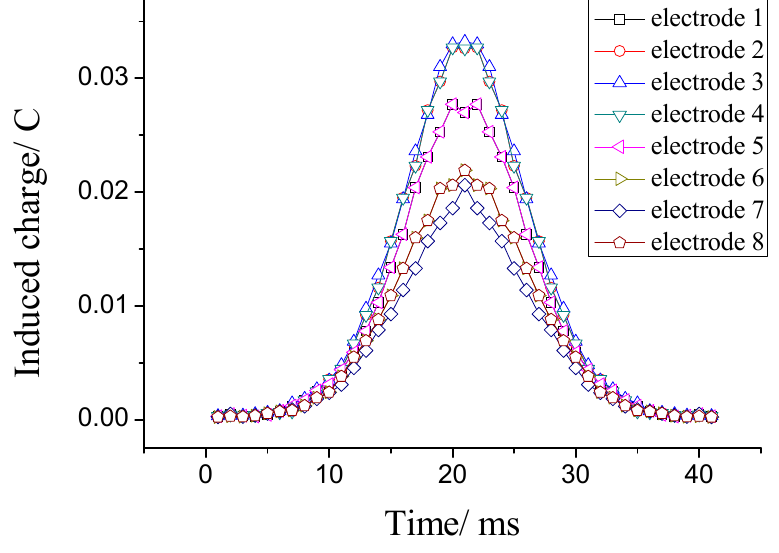
Figure 5. Induced charge on eight electrodes.